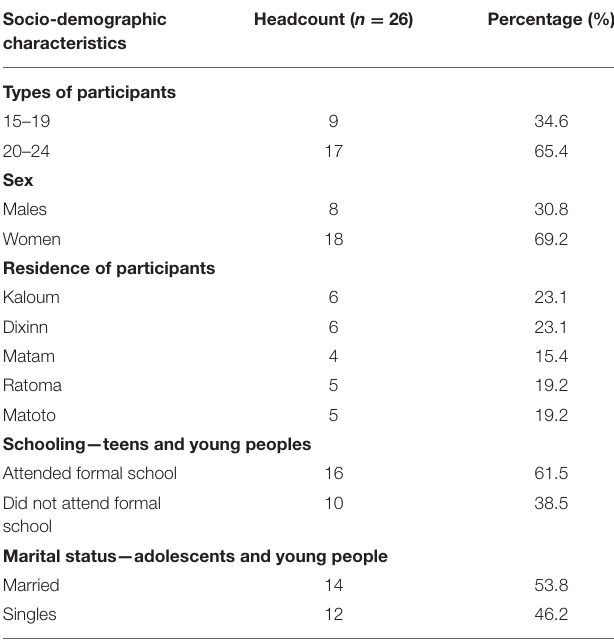
TABLE 1 | Characteristics of participants in the individual in-depth interviews